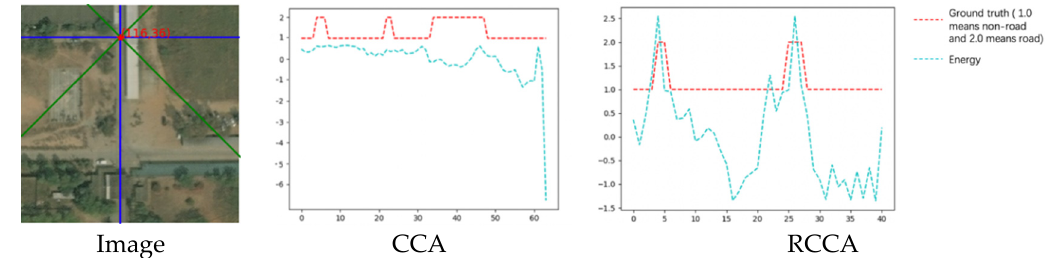
Figure 21. The energy line chart of two sampling area.